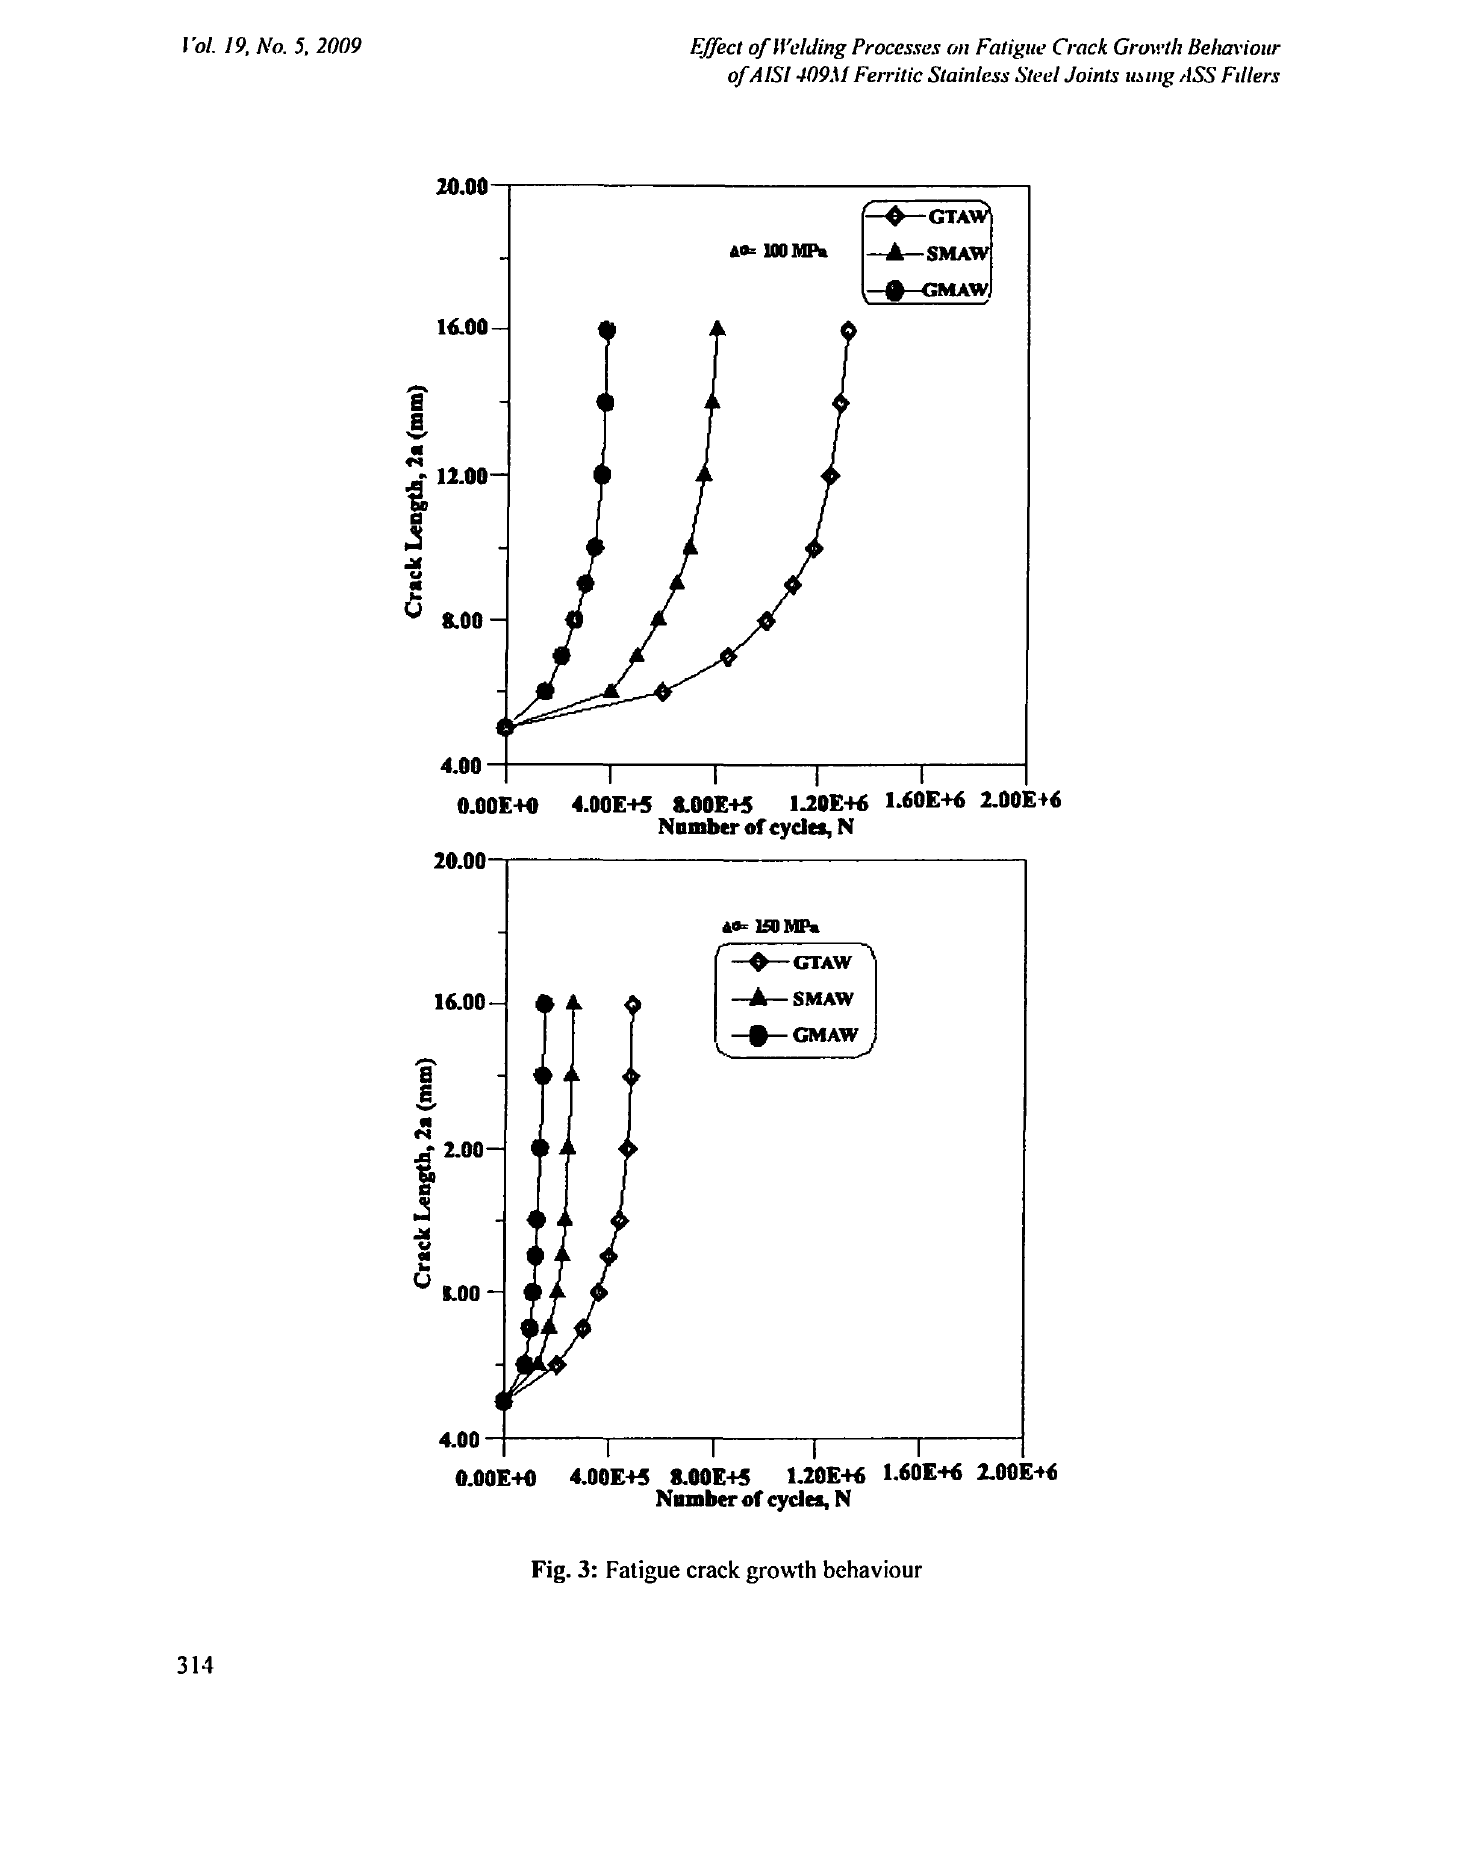
Fig. 3: Fatigue crack growth